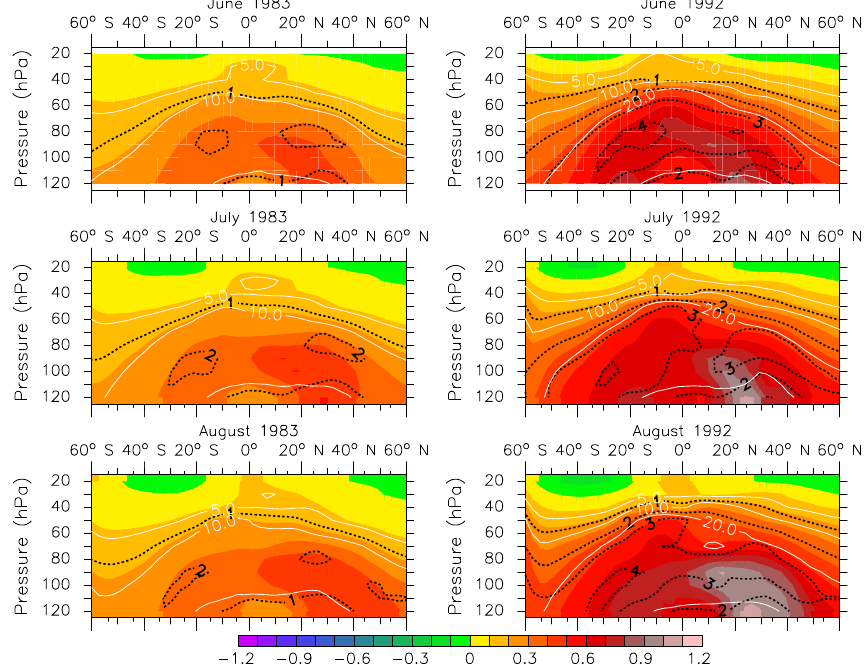
Figure 10. SWV (ppmv, colours) as absolute differences (VOL-NOVOL), zonally averaged as a near global (60 ◦ S–60 ◦ N) vertical cross section at a height between 120 and 20hPa for the months of June, July, and August in the year following the eruptions (1983 and 1992). White contours indicate the relative increase in SWV (intervals 5, 10, 20, and 50%) compared to the background value of NOVOL. Black dashed contours mark increases in units of standard deviation for the particular month in NOVOL (calculated over the time period 1979– 2013). The left column shows the El Chichón period, the right column the Mount Pinatubo period.